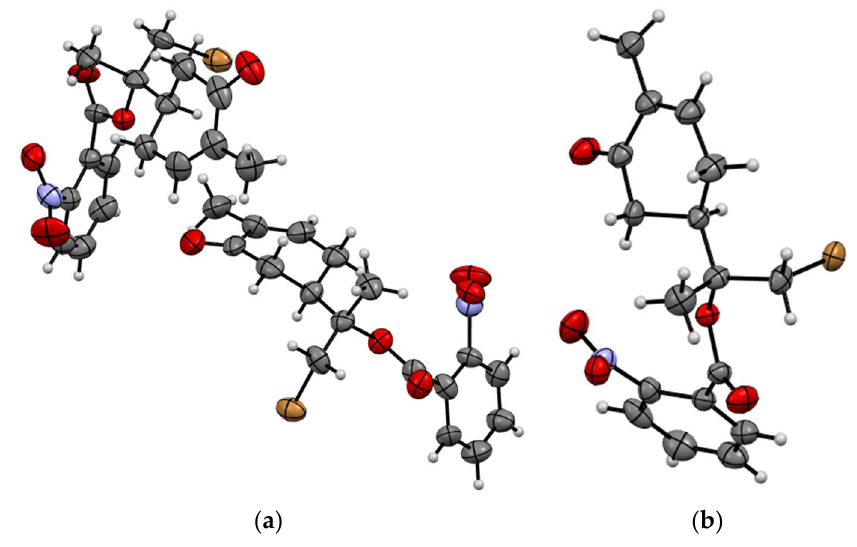
Figure 2. X-ray-determined structures of compounds: ( a ) bromoester 7 crystallised as dimers in the cell unit and ( b ) bromoester 8 . Atom colours: grey (C), white (H), blue (N), red (O) and light brown (Br)